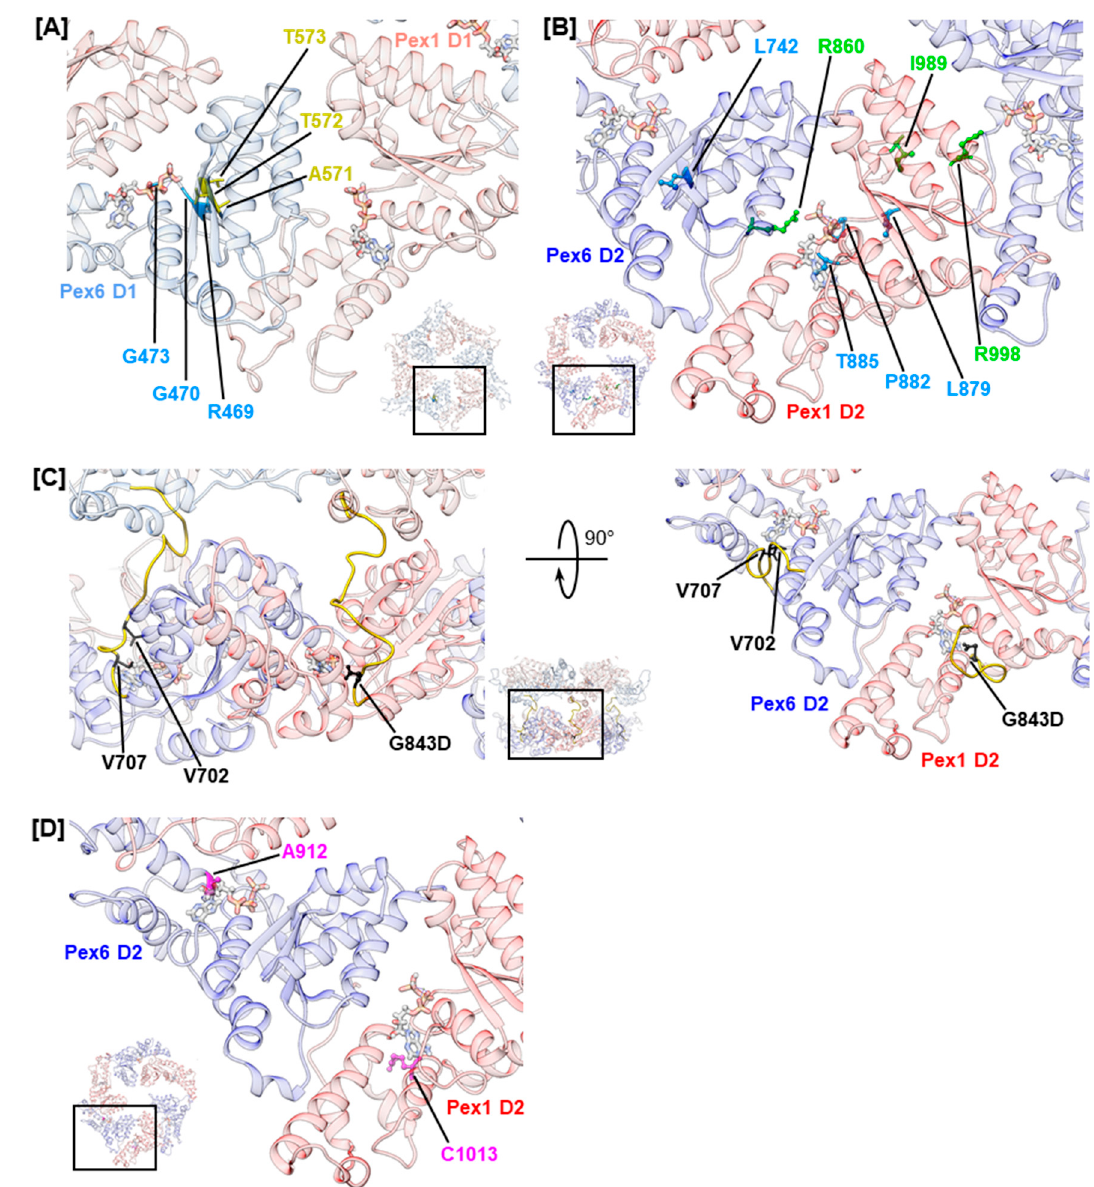
Figure 3. Structural mapping of mutations that concern the ATP binding pocket. Mutations in conserved motifs in D1 ( A ) and D2 ( B ). Amino acids concerned by mutations are shown as sticks and color coded as shown in Figure 2. Insets show the D1 ( A ) and D2 ( B ) ring as a top view with selection of enlarged area. ( C ) Mutations in the D1–D2 linker of Pex1 and Pex6 (right) shown in a front view (left) and top view (right). The linker peptide is colored in yellow and amino acids concerned by mutations are colored in black. The inset shows the front three protomers of the hexamer as a side view with selection of enlarged areas. The mutation G843D is shown as the mutated amino acid. ( D ) Mutations in the α -helical subdomain. Amino acids concerned by mutations are shown in pink. ATP is shown as sticks.